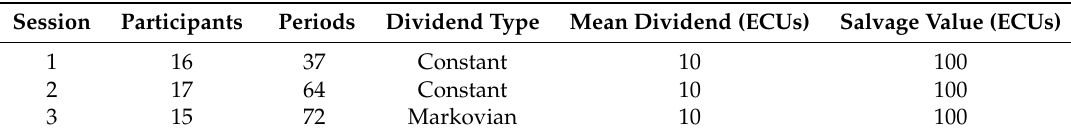
Table 2. Parameters for the Experimental